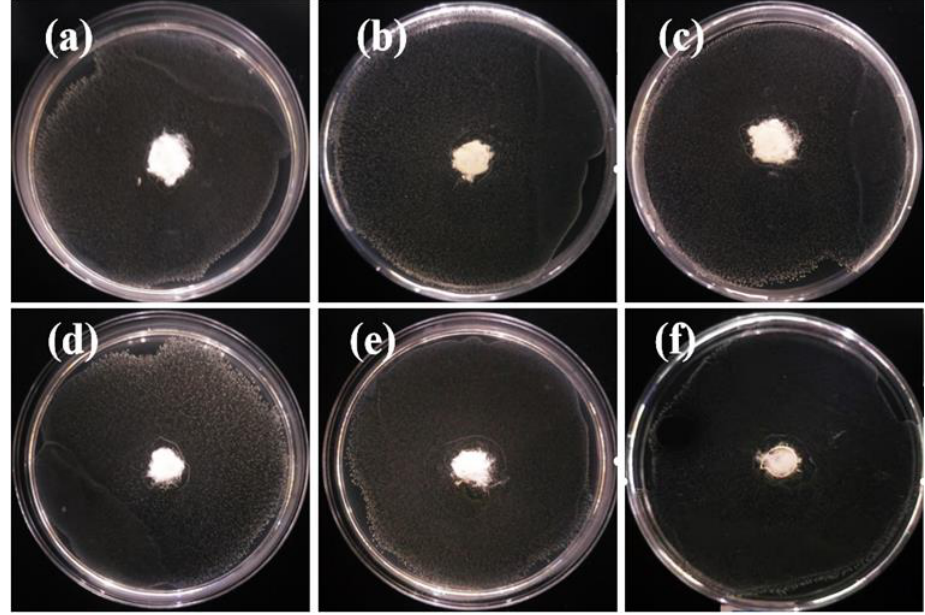
Figure 9. Antibacterial ( Escherichia coli ) activity measurements of e-spun PP fibers containing ZnO: ( a ) 0 wt.%; ( b ) 1 wt.%; ( c ) 2 wt.%; ( d ) 3 wt.%; ( e ) 4 wt.%; ( f ) 5 wt.%. The diameter of all containers was 9 cm.